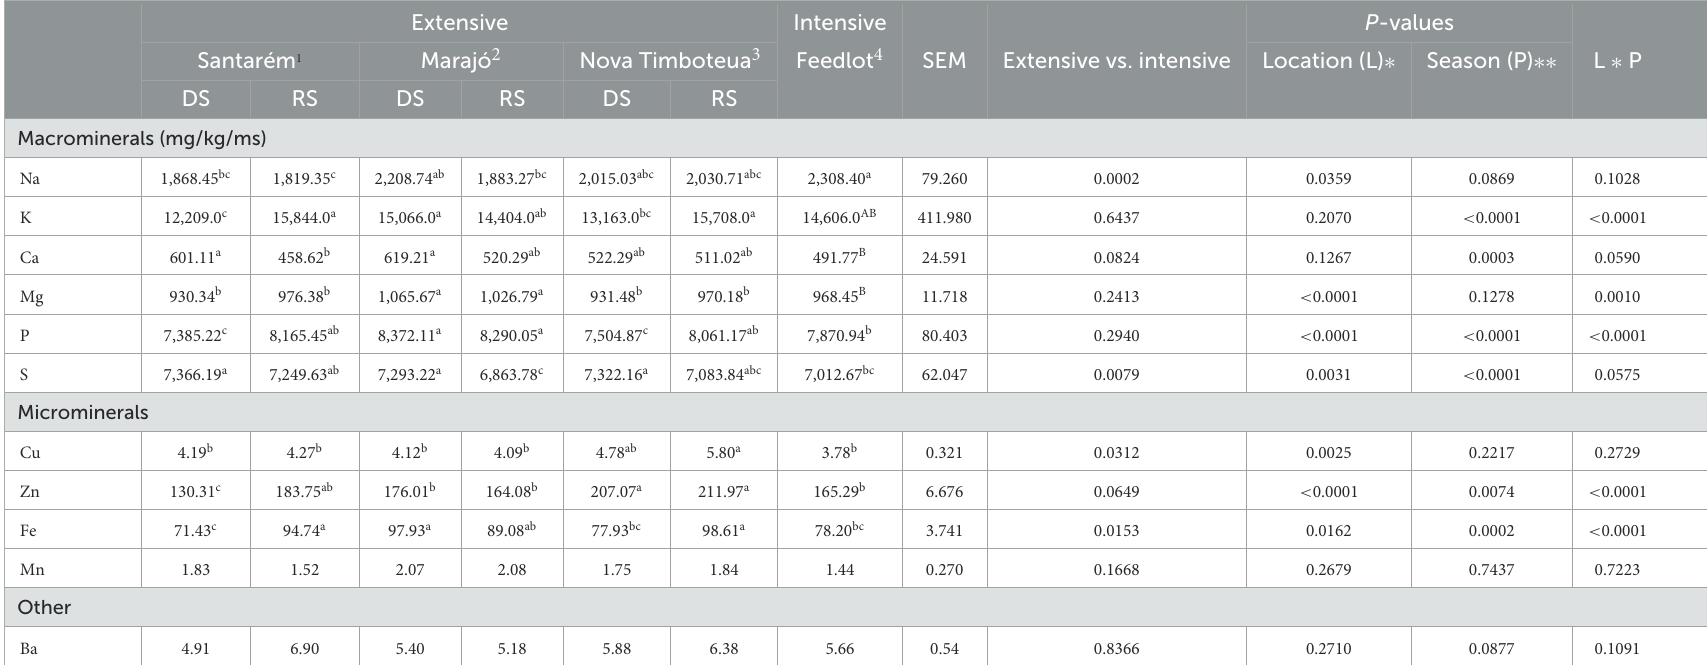
TABLE 1 Mineral composition (mg/kg) in the ribeye of crossbred buffaloes raised extensively in three types of production systems, during dry (DS) and rainy (RS) seasons, or intensely in feedlot, in the Eastern Amazonia (Brazil). Extensive Intensive P